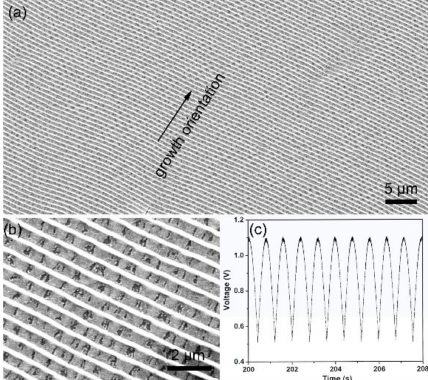
Figure 1. The typical ( a ) low- and ( b ) high-magnification SEM images of Au decorated Cu (Au@Cu) nanoarrays; ( c ) semi-sine wave voltage applied across the electrodes in the electrochemical deposition